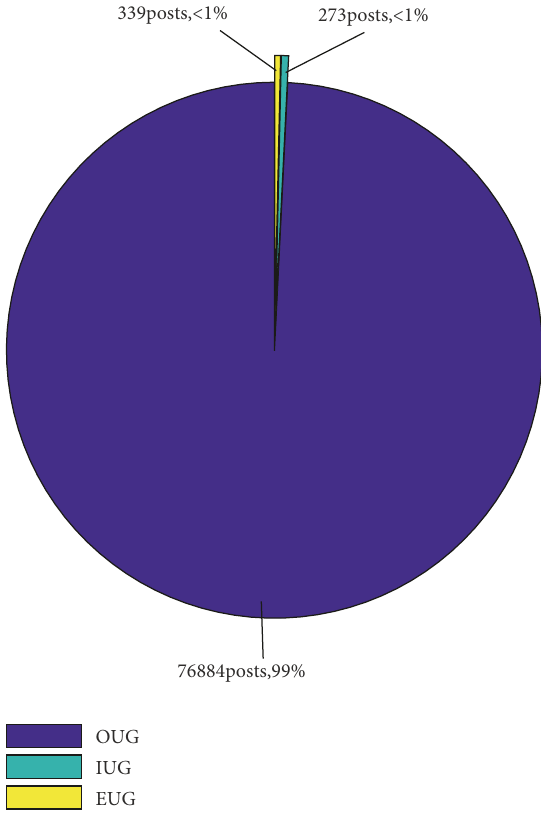
Figure 2: The ratio of posts of different